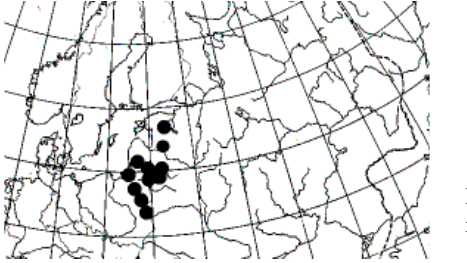
Fig. 3. Distribution of Verrucaria praetermissa in Eastern and East Central Europe (cid:3) modern records